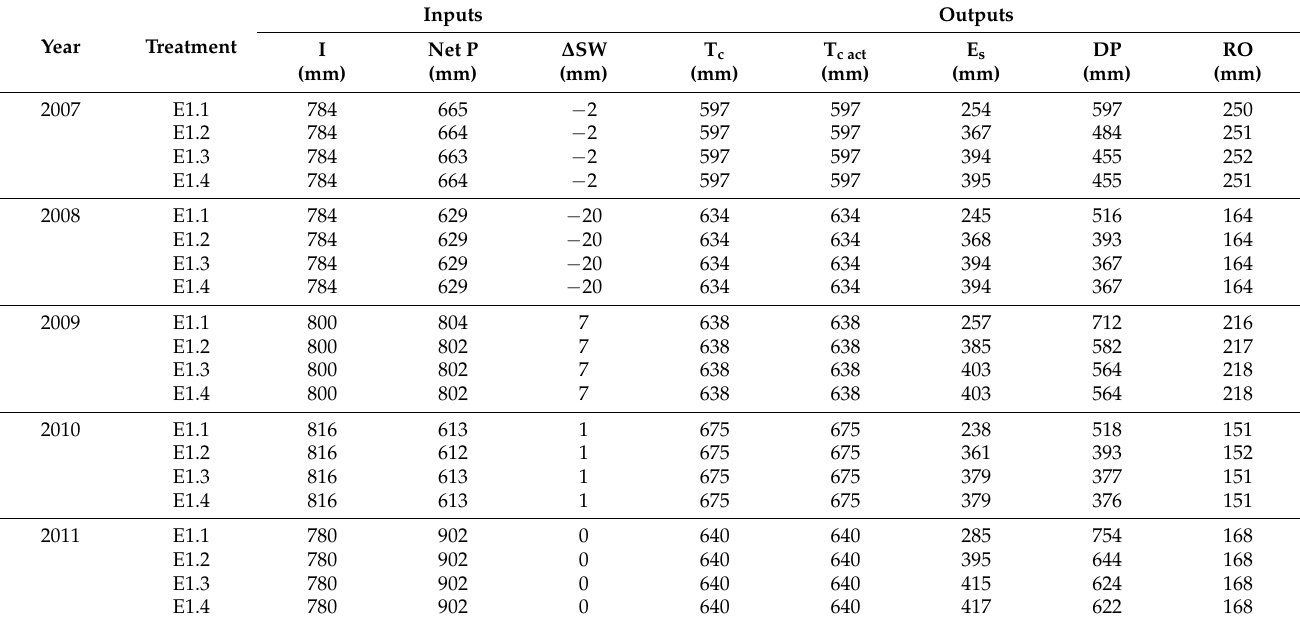
Table 14. Components of the annual water balance relative to the E1 growing seasons following the A&P approach.